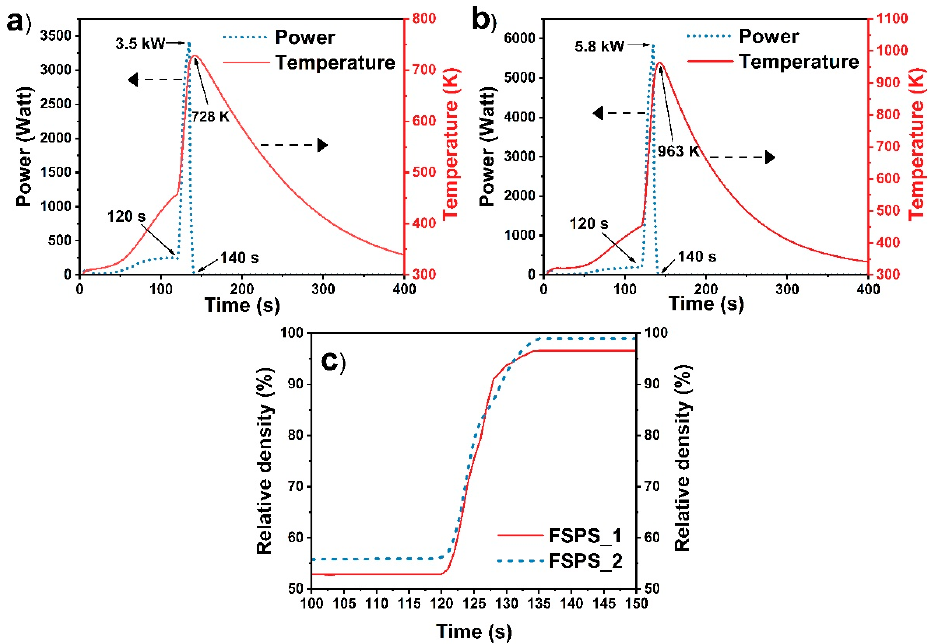
Figure 2. Typical FSPS conditions used in this study: ( a ) power–temperature profiles of FSPS_1; ( b ) power–temperature profiles of FSPS_2; ( c ) relative density variations of both samples during the process.